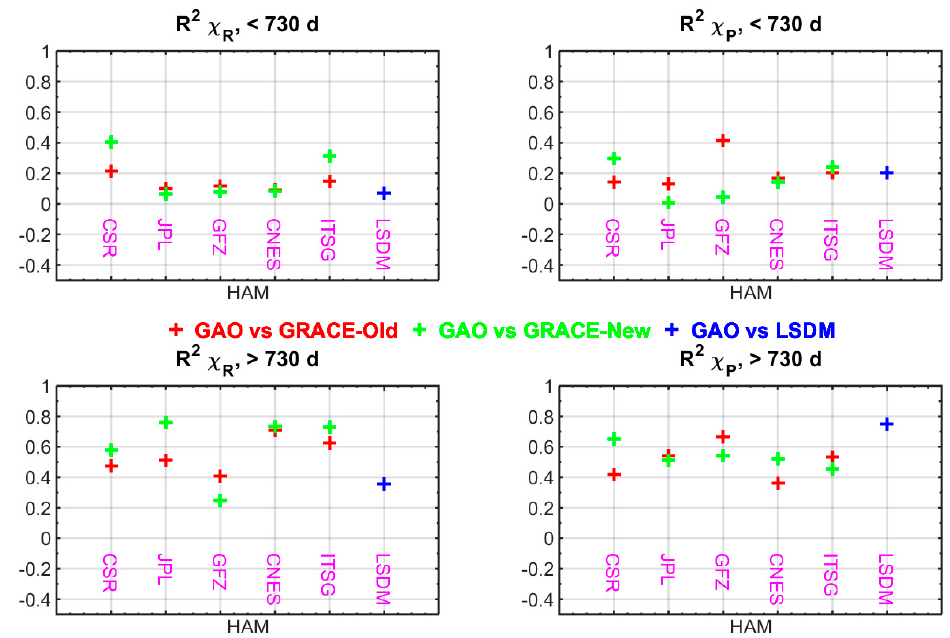
Figure 14. Coe ffi cients of determination (R 2 ) for χ R and χ P parts of short-term ( < 730 days) non-seasonal (top panel) and long-term ( > 730 days) non-seasonal (bottom panel) variation between GAO and HAM Figure 14. Coefficients of determination (R 2 ) for χ R and χ P parts of short-term (<730 days) computed from GRACE solutions and the LSDM. non-seasonal (top panel) and long-term (>730 days) non-seasonal (bottom panel) variation between GAO and HAM computed from GRACE solutions and the LSDM.